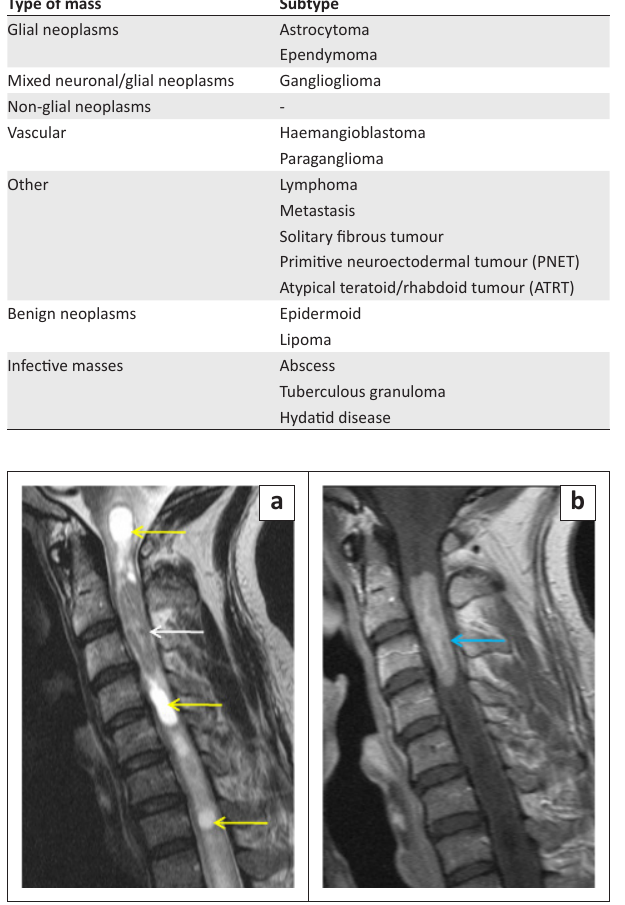
FIGURE 1: Intramedullary ependymoma in a 41-year-old man. (a) Sagittal T2- weighted image demonstrates a heterogeneous, well-circumscribed mass (white arrow) with extensive syrinx formation (yellow arrows); (b) Contrast- enhanced T1-weighted image demonstrates intense contrast enhancement of the tumour (blue arrow).